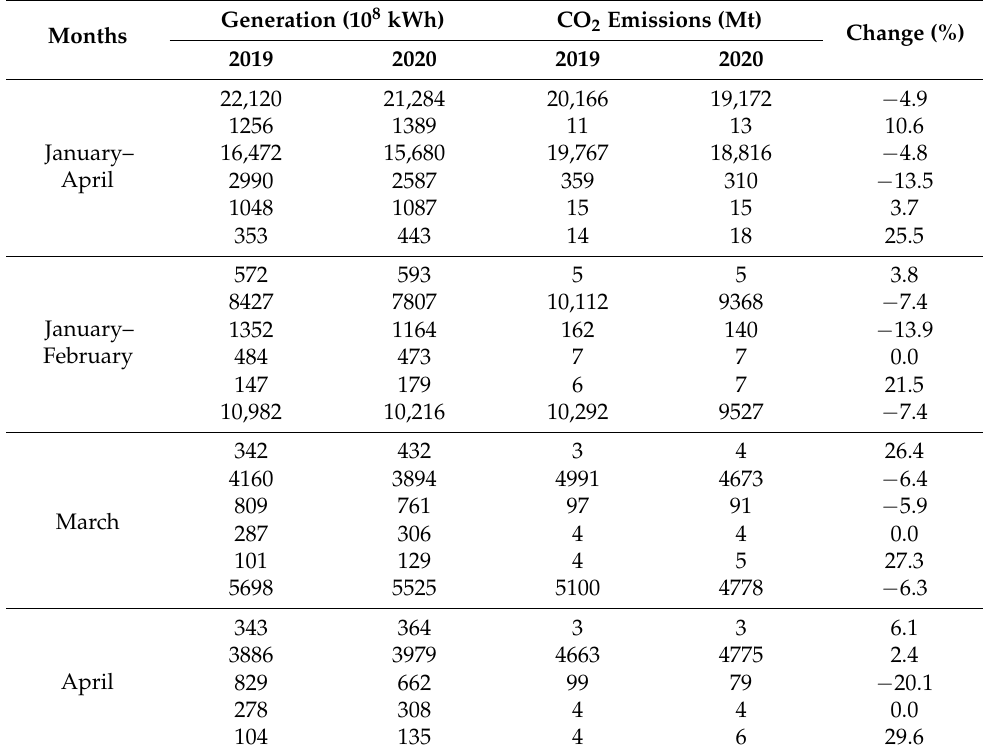
Table 4. China nationwide electricity-generation CO 2 changes in January–April 2020 compared with same months in